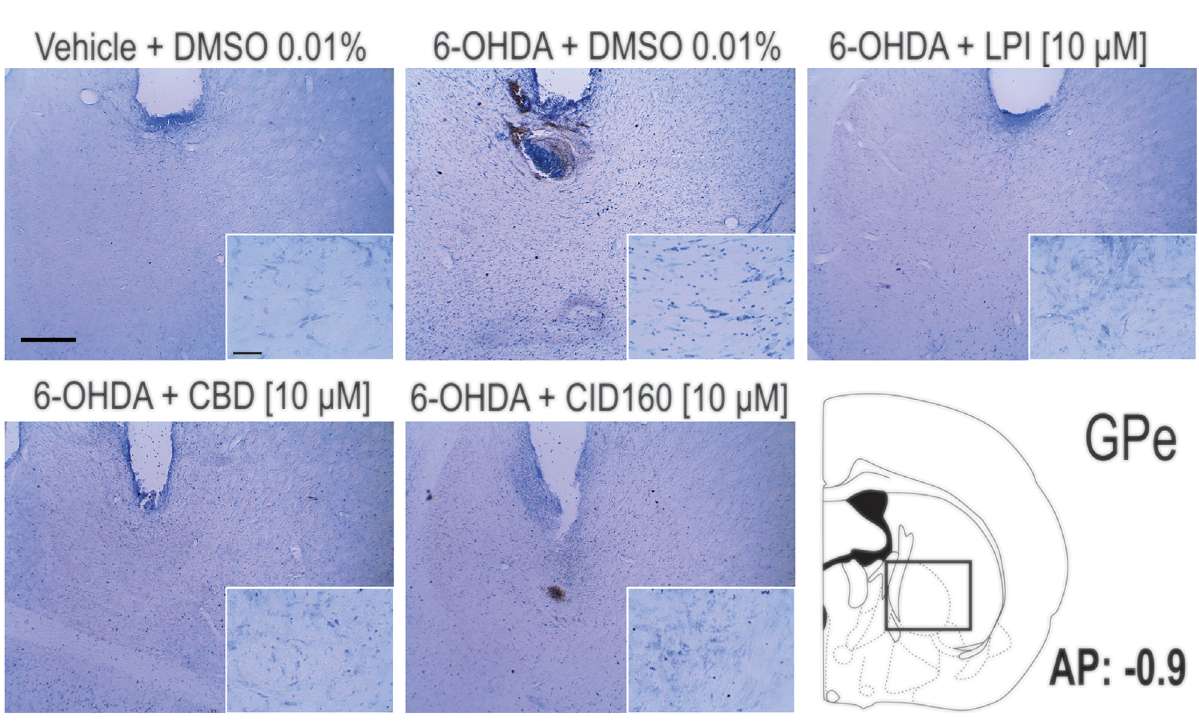
FIGURE 8 Pallidal cell morphology and veri fi cation of the correct placement of the cannula in the nucleus of the GPe. The photomicrographs show the images obtained via theNissl stainingoftheGPeandtheplacementofthecannulainthedorsalareaoftheGPe.Photomicrographsweretakenat4x and 40x and the scale bar represents 500 and 50 μ m,